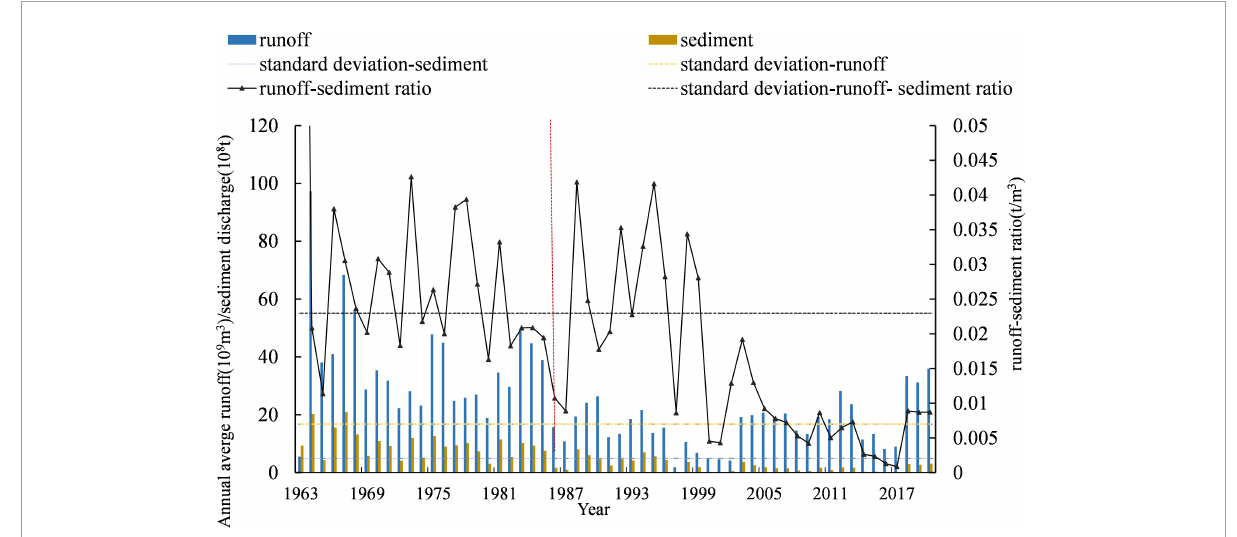
FIGURE1 The trend of runoff and sediment changed from 1963 to 2020 at Lijin